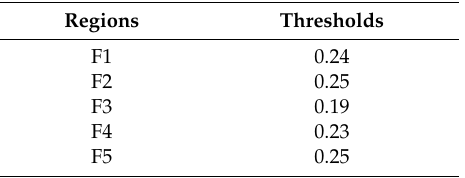
Table 11. The thresholds of five regions in the fresco.